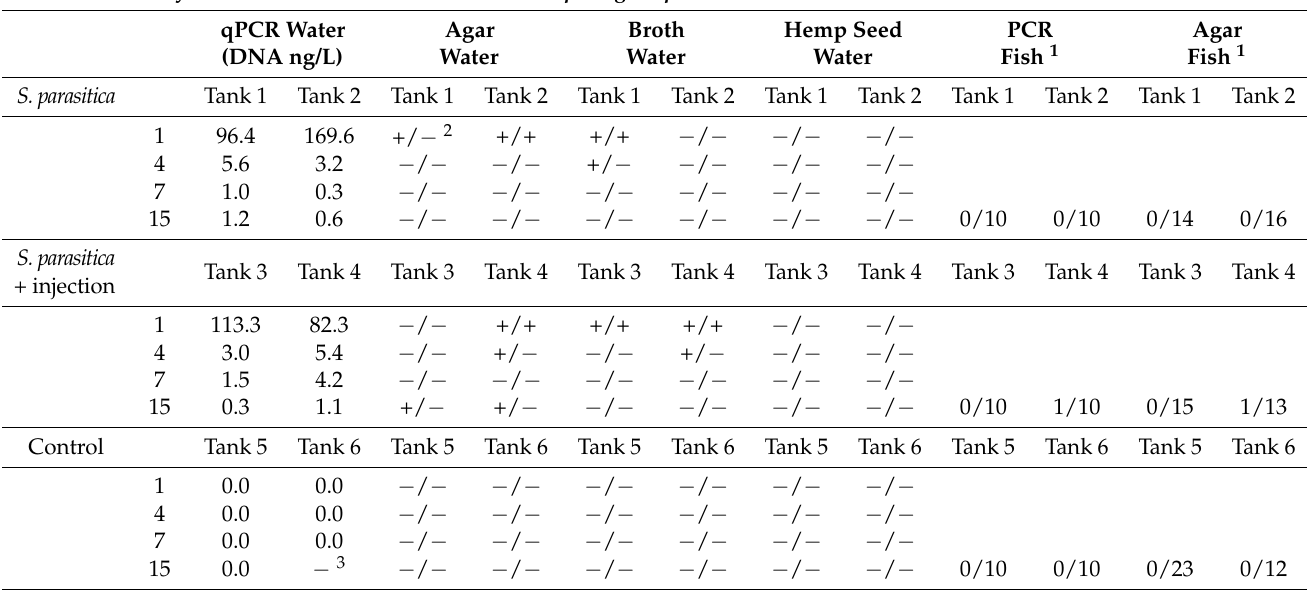
Table 3. Detection of S. parasitica from water and fish samples with qPCR and microbiological methods in an S. parasitica exposure experiment, in which 17 fish per tank, in four tanks (1–4), where exposed to S. parasitica spores (concentration 3 × 10 4 spores/L) and two control tanks (5 and 6) received sterile MilliQ water. Exposed fish in the tanks 3 and 4 were additionally sham-injected to mimic vaccination